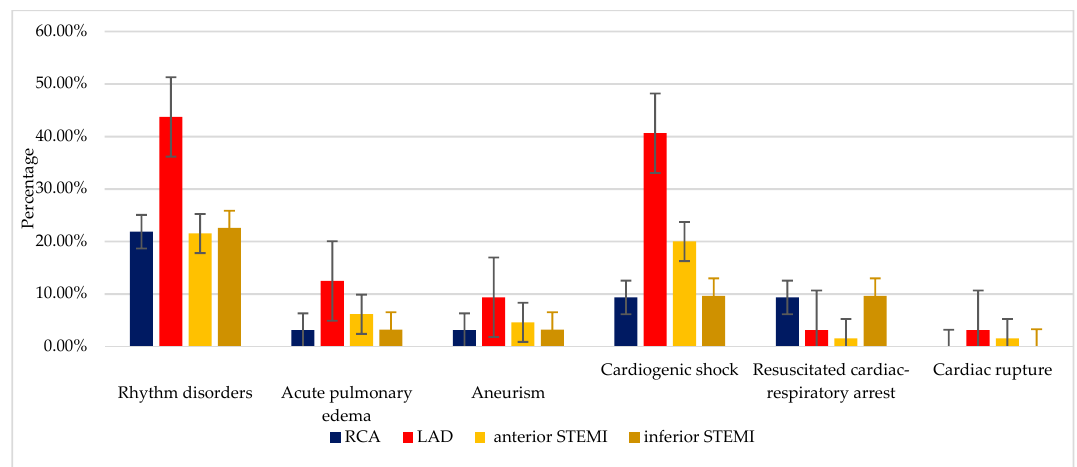
Figure 2. The prevalence of complications depending on the culprit artery and STEMI for NRP+ group Legend: RCA: right coronary artery ( n = 27); LAD: left anterior descending artery ( n = 64); STEMI: ST-segment elevation myocardial infarction (anterior STEMI: n = 65 and inferior STEMI: n = 31).